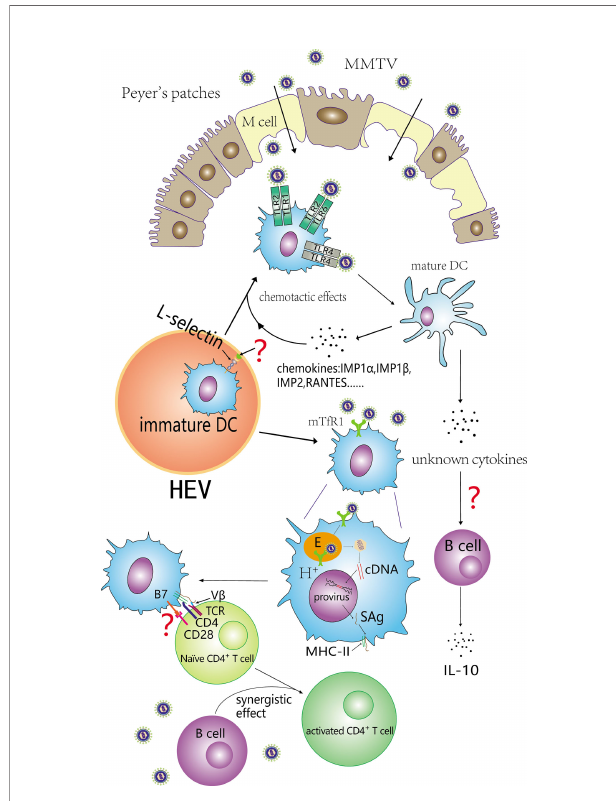
FIGURE 2 | Contribution of DCs to the SAg response. Immature DCs are recruited from blood depends on L-selectin and subsequently activated by binding with MMTV. Both TLR4 and TLR2 can take part in the activation of immature DCs. Activated DCs (mature DCs) secrete some chemokines that facilitate immature DCs recruitment. In addition, some cytokines released by activated DCs can induce B cells to secrete IL-10, and inhibit the antiviral immune response. MMTV can also infect DCs and its SAg can be ef fi ciently presented to cognate V b CD4 + T cells. DCs and B cells exert a synergistic effect on the activation of naïve CD4 + T